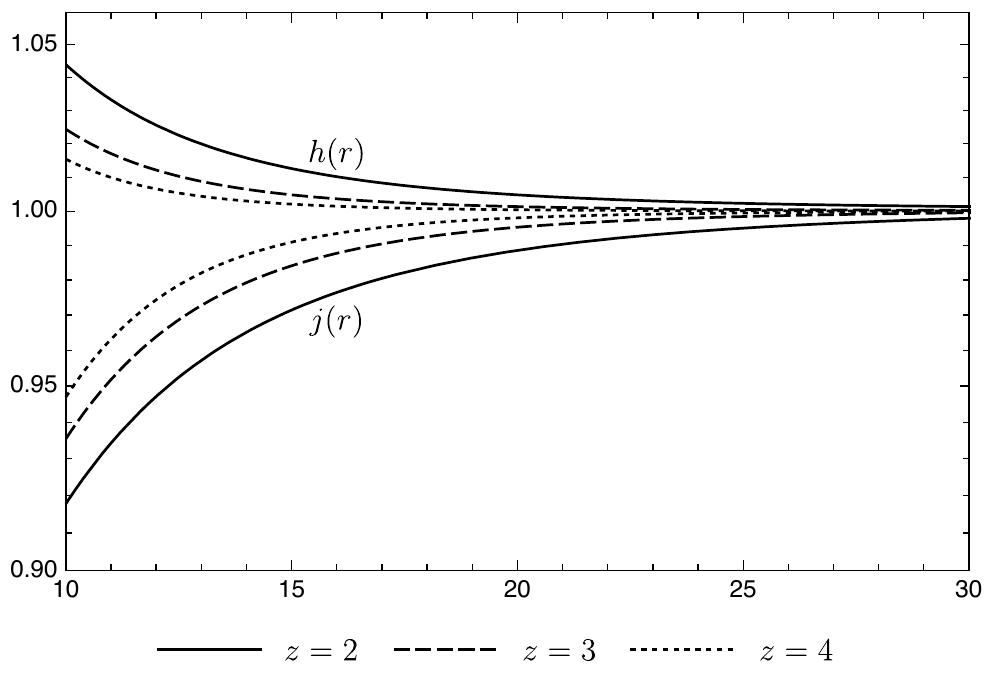
Figure 1 . The figure plots the gauge field functions h ( r ) and j ( r ) as a function of radial distance r . This is an example of a large black hole with R